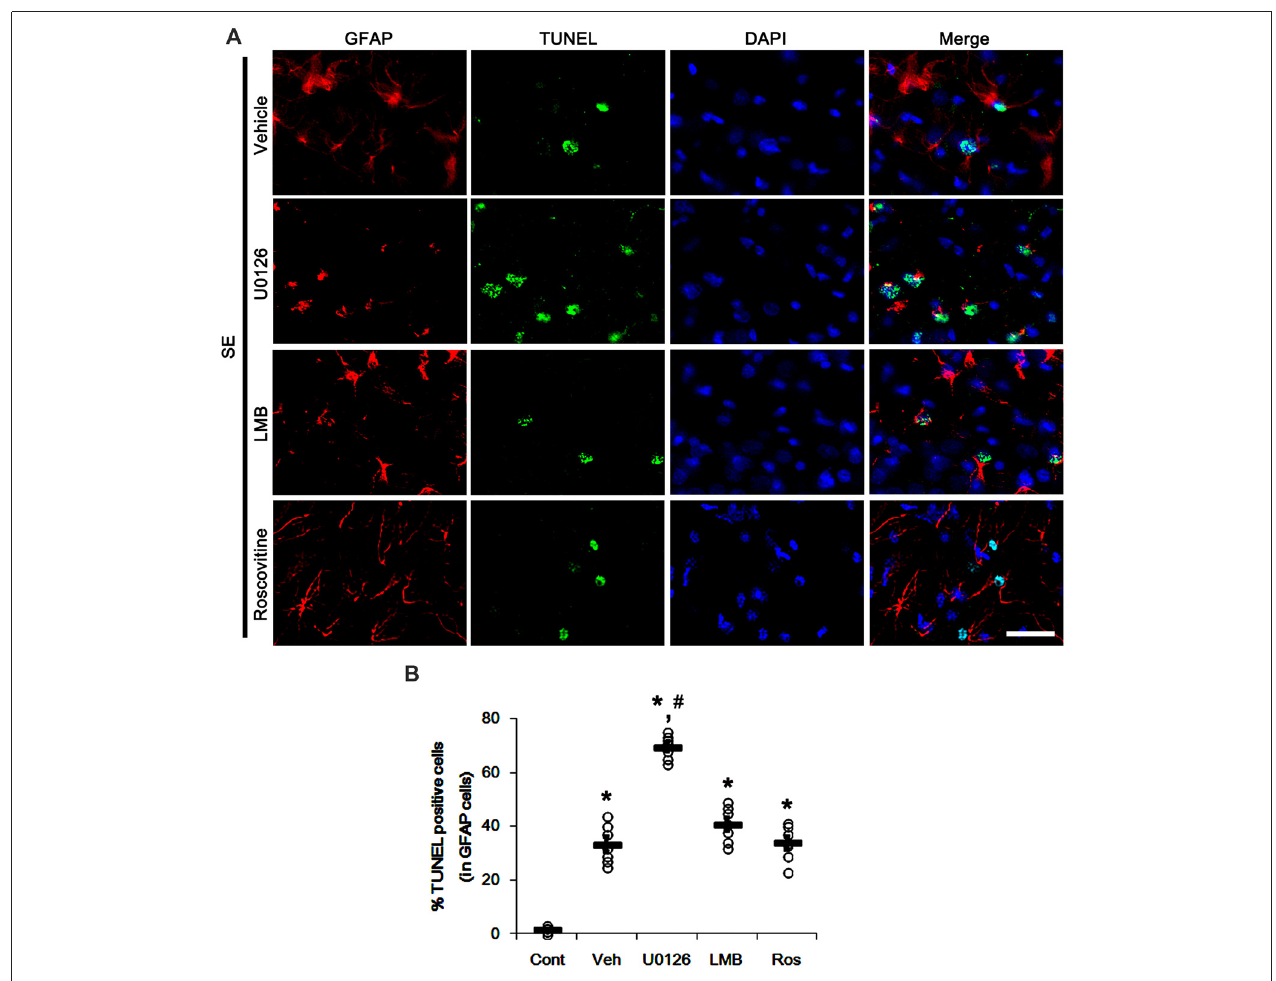
FIGURE 7 | Effects of U0126, LMB and roscovitine on astroglial apoptosis in the molecular layer of the dentate gyrus following SE. (A) Representative photos demonstrating TUNEL-positive astrocytes. As compared to vehicle, U0126 exacerbates SE-induced astroglial apoptosis, while LMB and roscovitine do not. Bar = 12.5 µ m. (B) Quantification of the fractions of TUNEL-positive astrocytes in total astrocytes within the molecular layer of the dentate gyrus. Open circles indicate each individual value. Horizontal bars indicate mean value. Error bars indicate SEM ( ∗ ,# p < 0.05 vs. control and vehicle, respectively; n = 7,